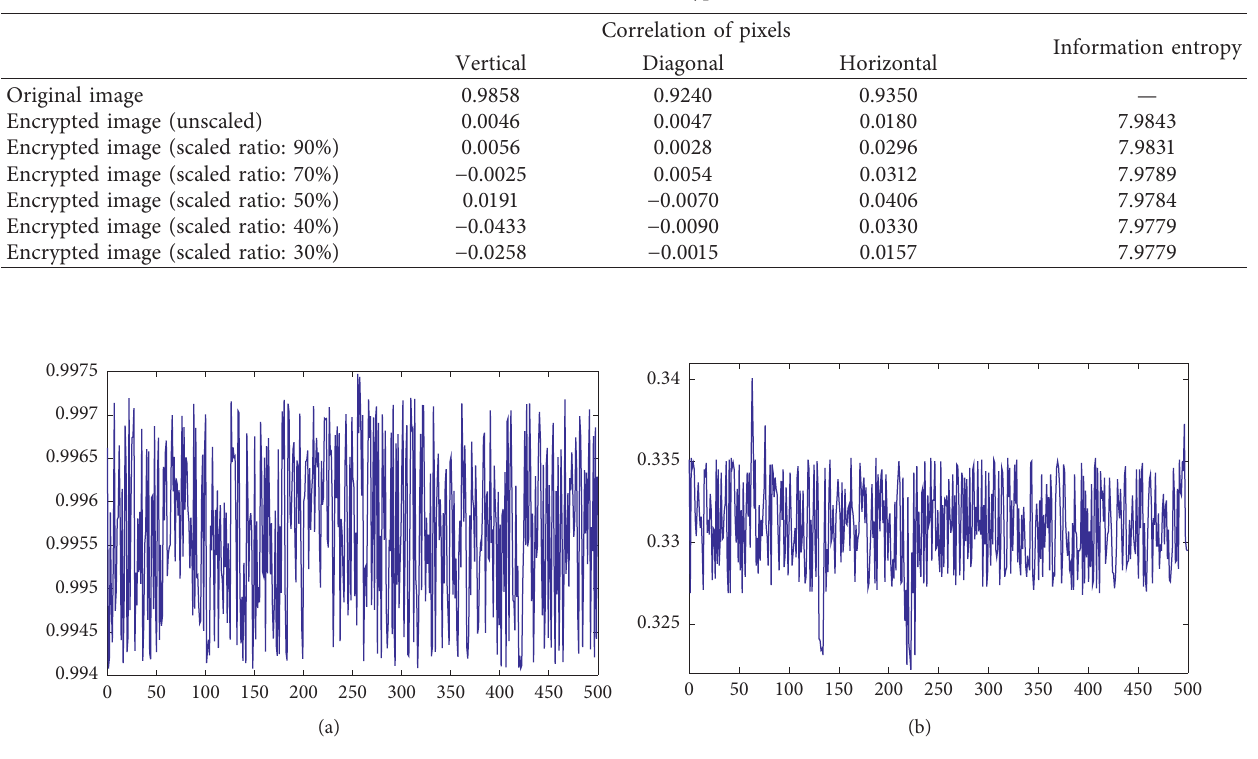
Figure 7: Only one pixel is changed by the (a) NPCR and (b) UACI,